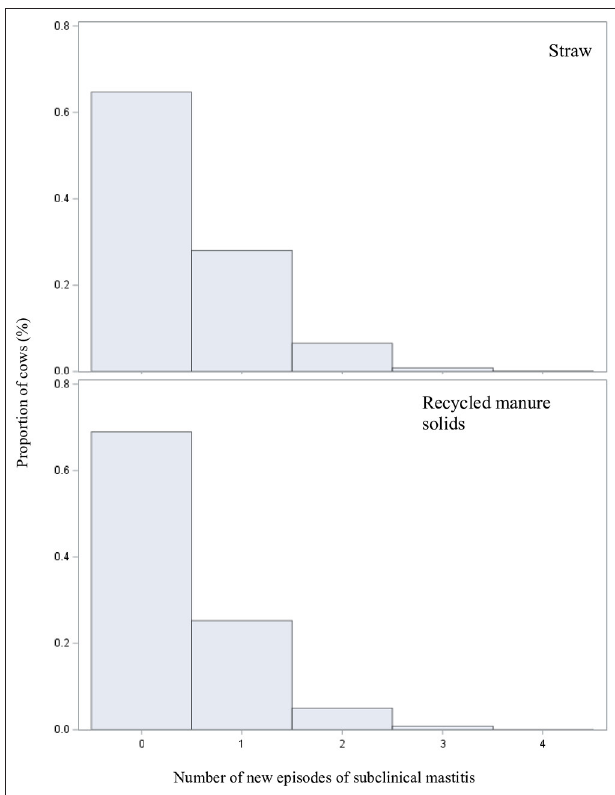
FIGURE 4 | Distributions of number of newly acquired subclinical mastitis (defined as a linear score ≥ 4.0 on first test followed by a linear score = 4.0 on second test) for a given cow by bedding type in 43,546 pairs of DHI tests from 11,031 cows from 60 straw-bedded farms (top) and 20 recycled manure solids farms (bottom).